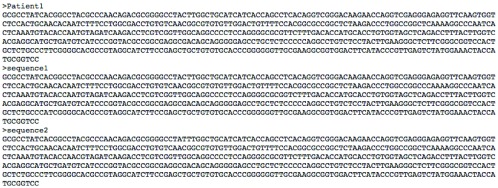
Patient file format.